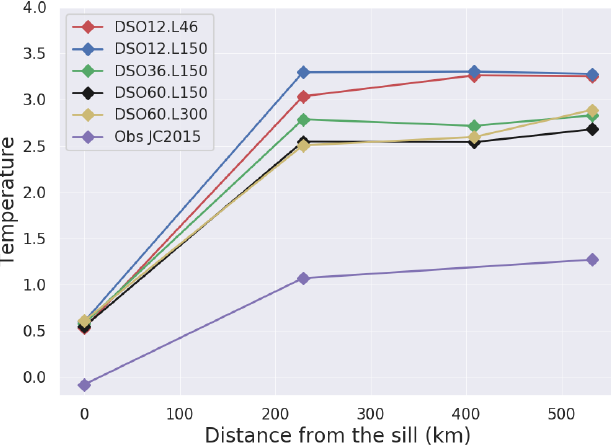
Figure 17. Time mean minimum bottom temperature for five sen- sitivity simulations at the location of the observational arrays. The results of Jochumsen et al. (2015) are reported as Obs